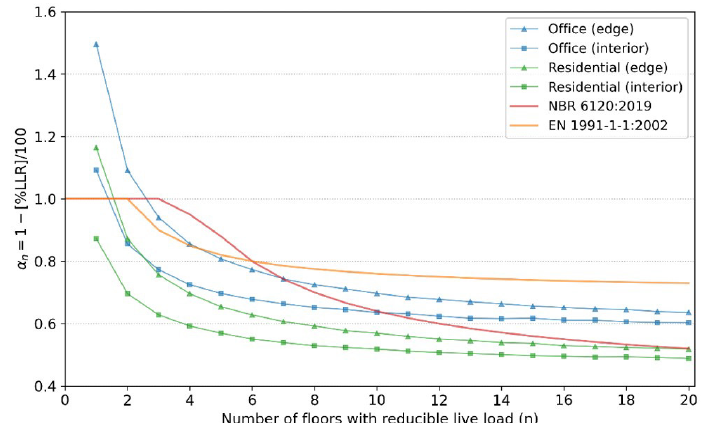
Figure 9. Comparison of the stochastic model results with the live load reduction factor allowed in the Brazilian design code for office and residential